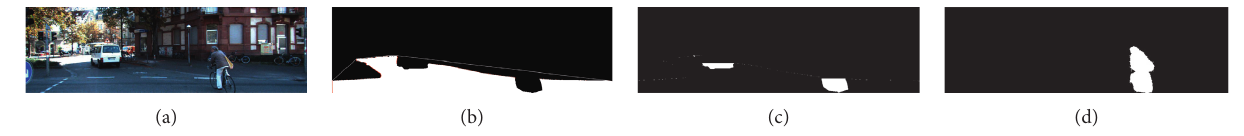
Figure 7: The detection algorithm of pedestrian on the road. (a) Original image. (b) Road periphery envelope. (c) Pedestrian source point. (d) Detection